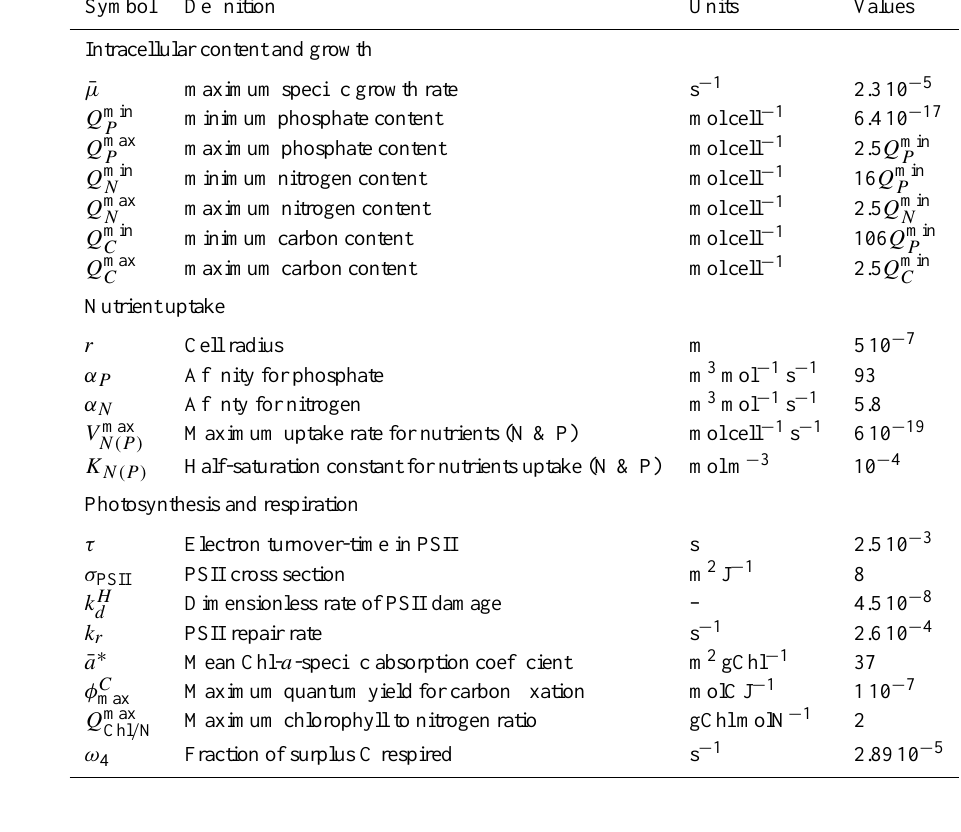
Table 4. Model parameters for phytoplankton.